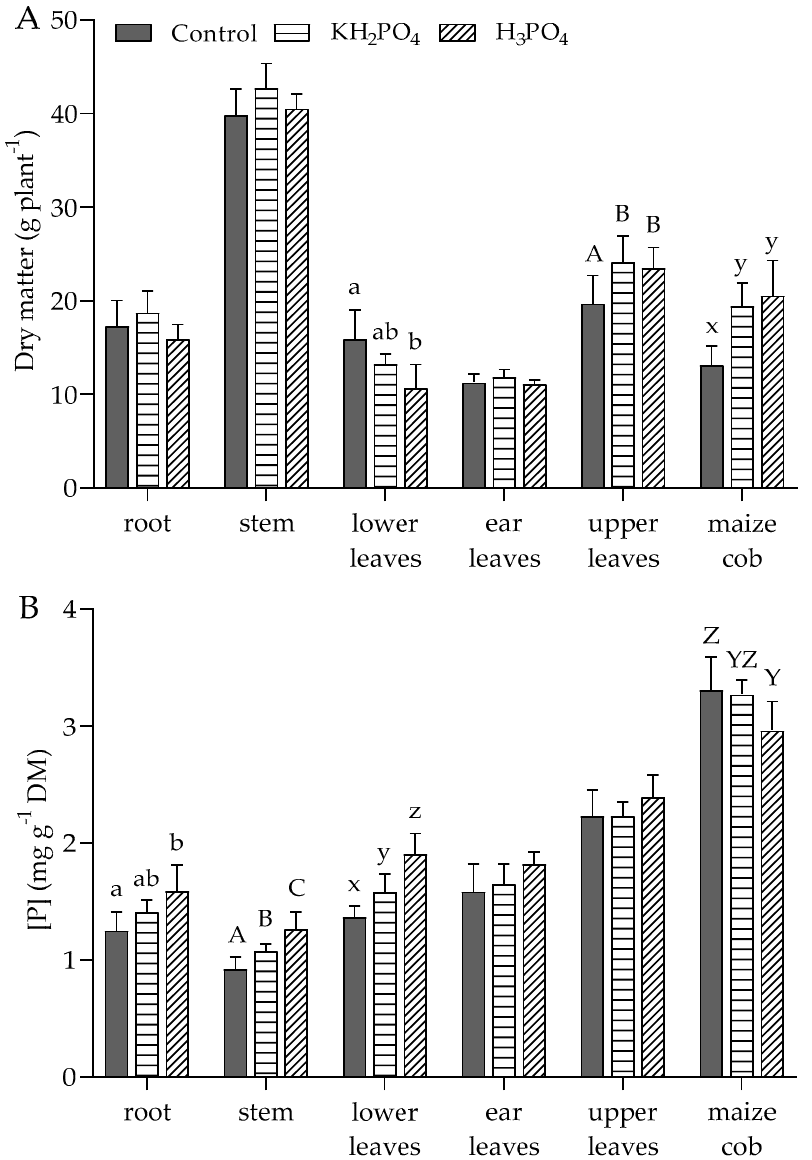
Figure 3. ( A ) Dry matter in g plant − 1 and ( B ) phosphorus concentration (P) in mg g − 1 dry matter of the investigated parts of the plant were analyzed after harvest at flowering (BBCH 65). Plant material was separated into root, stem, lower leaves (leaves below the ear leaves), ear leaves, upper leaves (leaves above the ear leaves), and maize cobs (+husk leaves). Control without P fertilization (control) or three foliar applications of 200 mM potassium dihydrogen phosphate (KH 2 PO 4 ) or phosphoric acid (H 3 PO 4 ) at 40, 46, and 53 days after sowing. Bars represent means + SD ( n = 5). Upper and lower case letters indicate significant differences between treatments within the examined parameters (ANOVA with Duncan test, p ≤ 0.05).